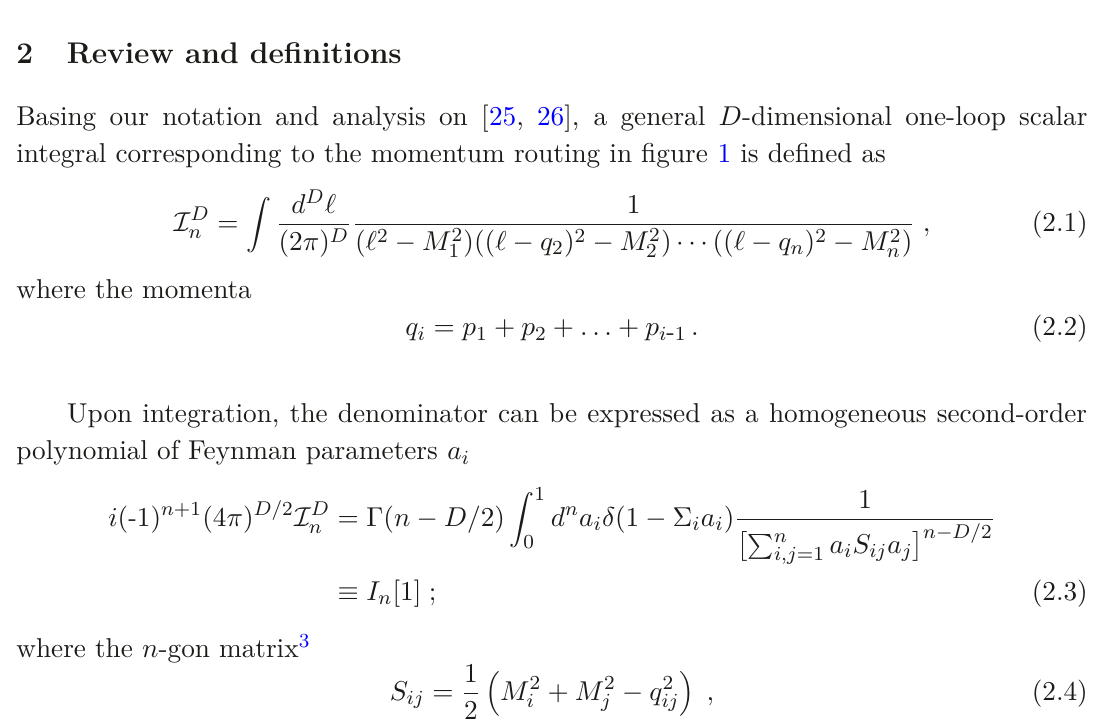
Figure 1 . Diagrammatic representation of the general one-loop integral function I D The external momenta p i should always be considered